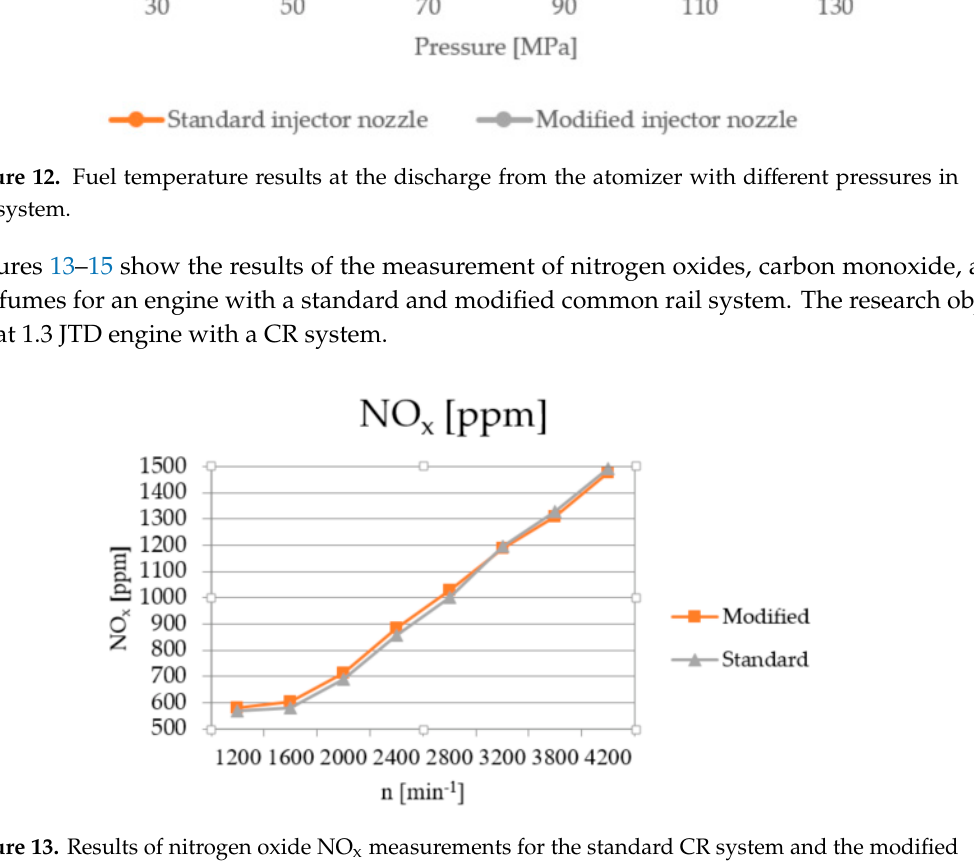
Figure 13. Results of nitrogen oxide NO x measurements for the standard CR system and the modified CR system.